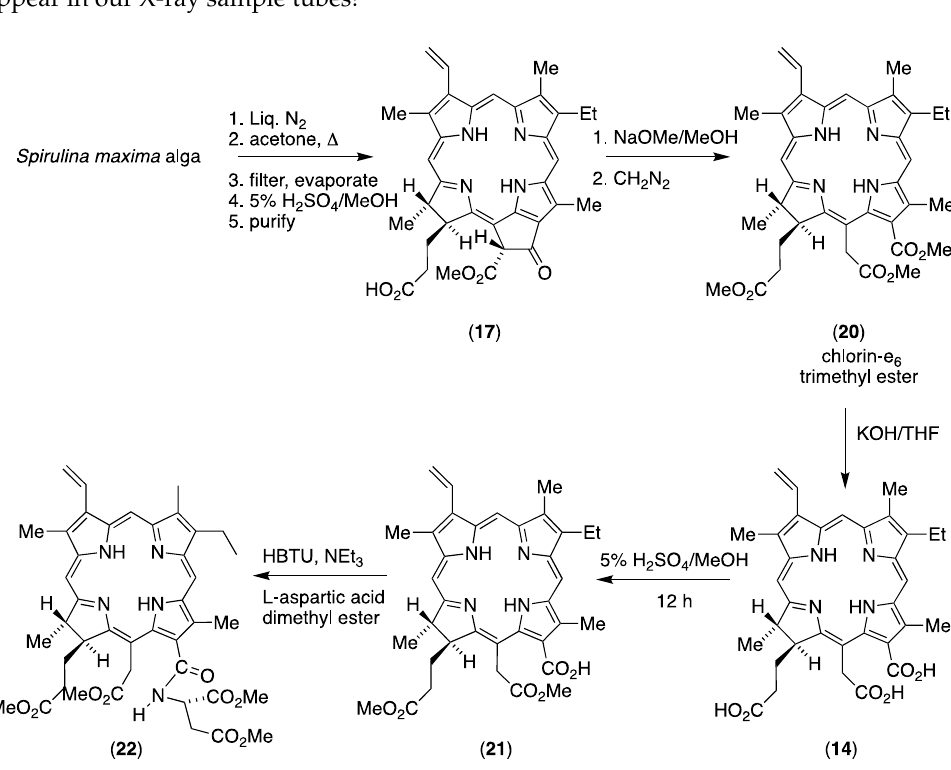
Figure 6. X-ray structure of authentic NPe6 tetramethyl ester ( 23 ). With the knowledge that the aspartyl residue is indeed conjugated to the 15 2 -position, the question next raised was “Why?” This regiochemistry was not expected and there was some disbelief even on the part of the manufacturer/distributor when the 15 2 -conjugate